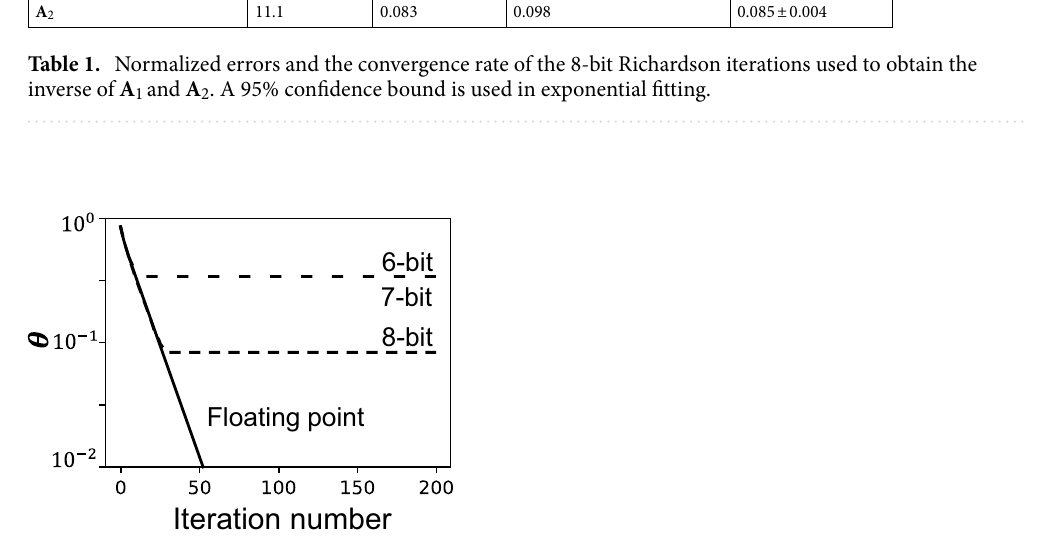
Figure 2. Normalized errors of the iterative solutions θ k vs. the iteration number k for the inversion of A 2 ( κ =11.1) using 8-bit, 7-bit, and 6-bit fixed-point iterative solvers. The error of the floating-point iterative solver is plotted for reference.